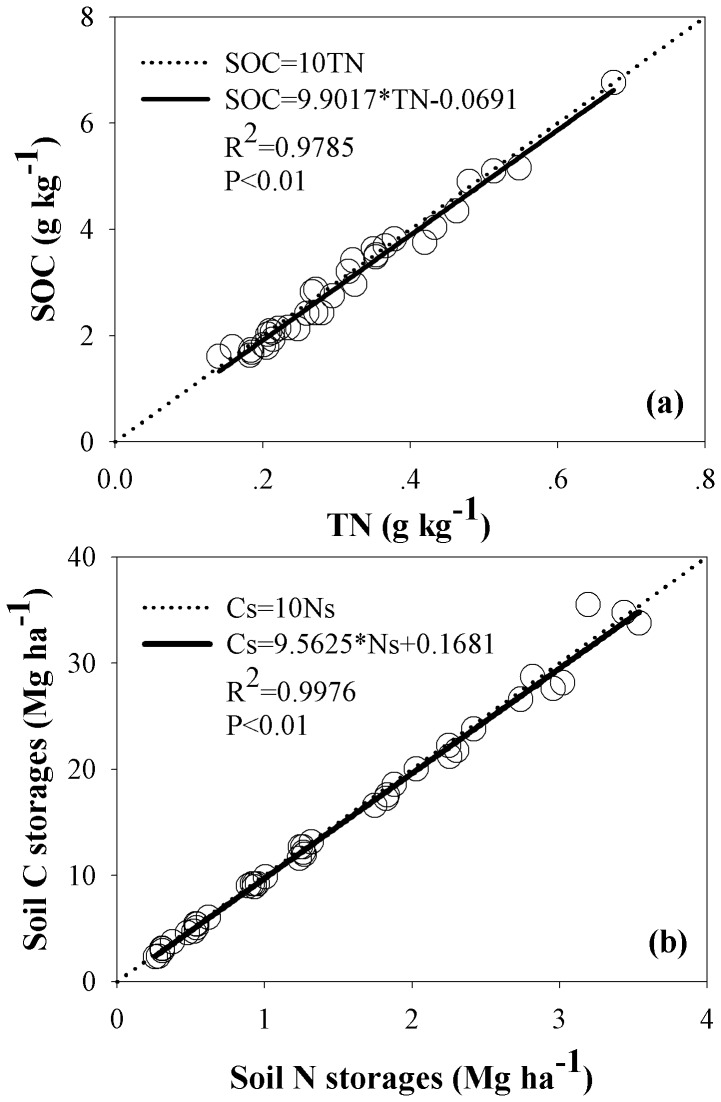
Relationship between SOC and TN, soil OC storages and soil N storages, and accumulative soil C storages and soil N storage.